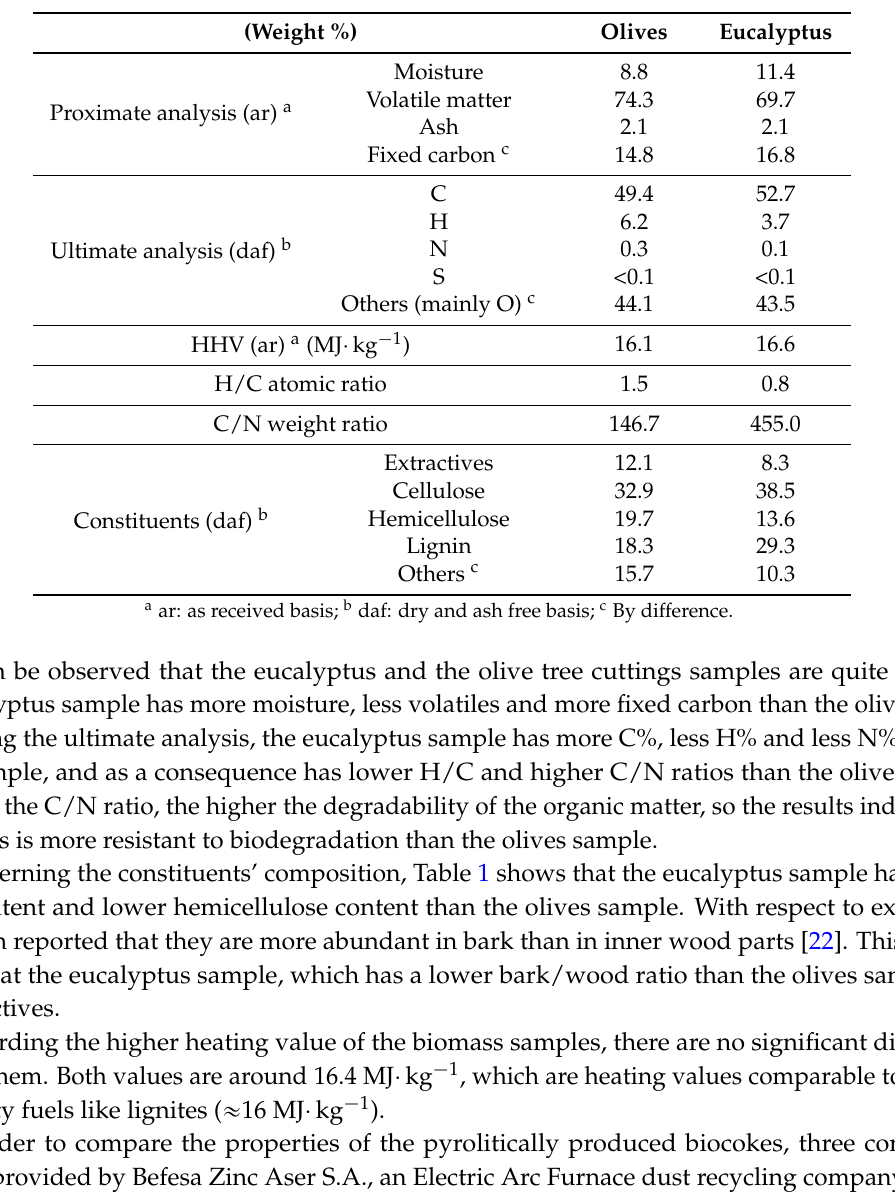
Proximate analysis (ar)